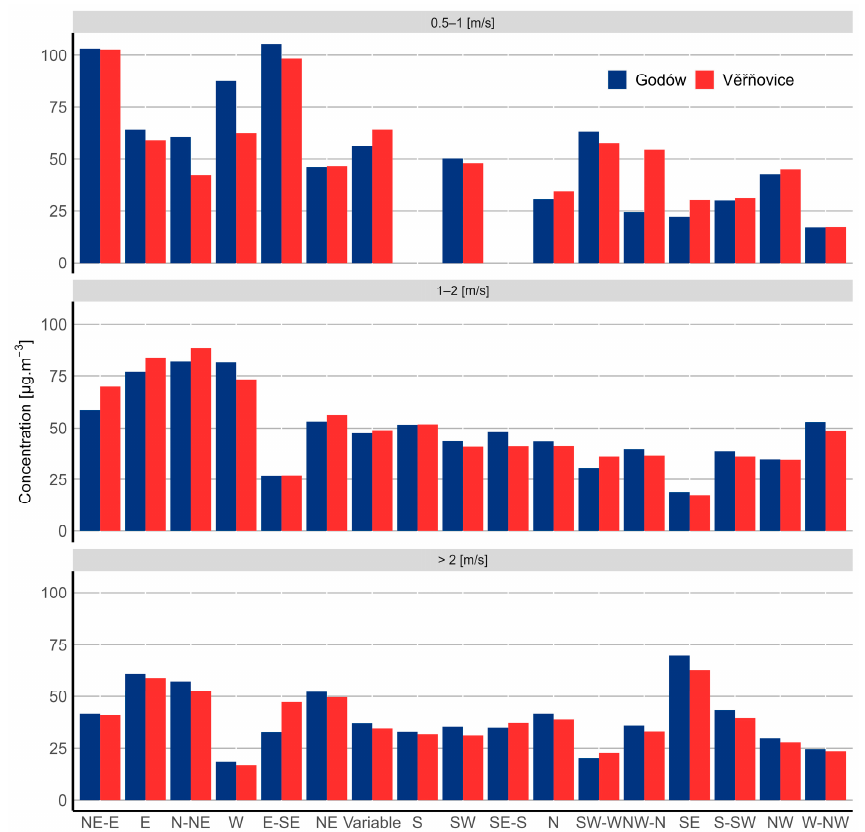
Figure 13. Average PM 10 concentrations by individual daily wind types and wind speed, Vˇeˇrˇnovice and Godów site, 2011–2020.